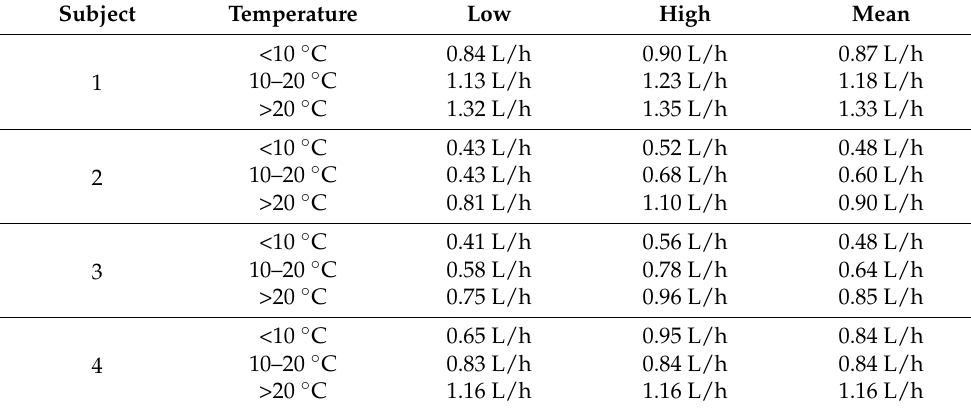
Table 3. Participant sweat rates (L/h) for the four participants that completed multiple training sessions within each Wet-Bulb Globe Thermometer range. Sweat rate values shown as highest, lowest, and mean values for each range.